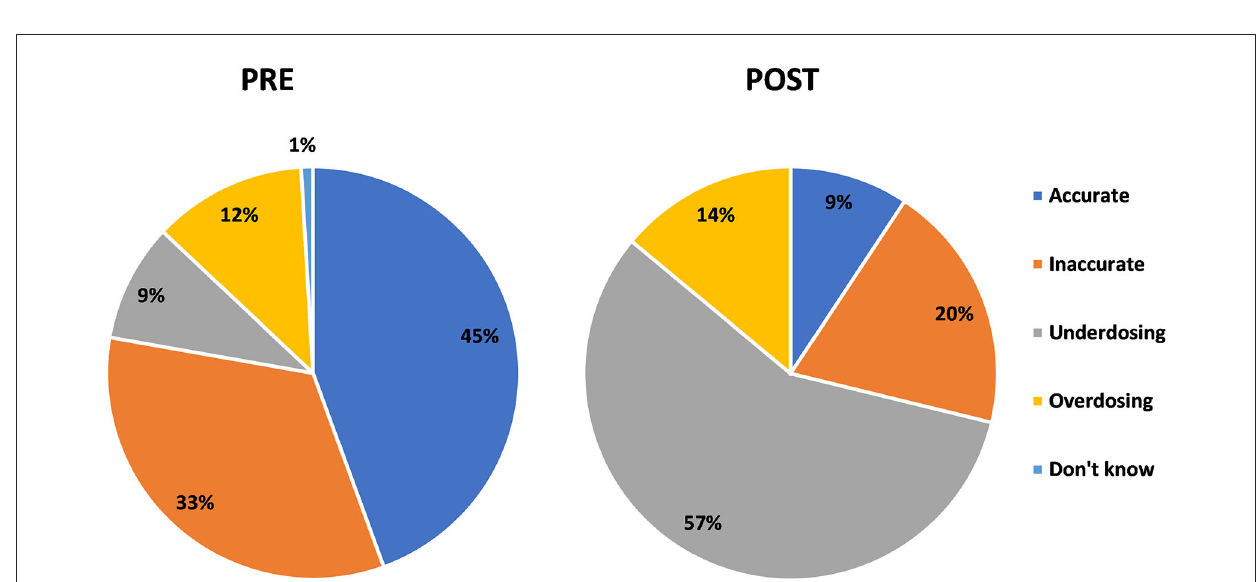
FIGURE9 Pre- and post-intervention responses for any other method (than the six tools shared) that can be used for the administration of oral liquid